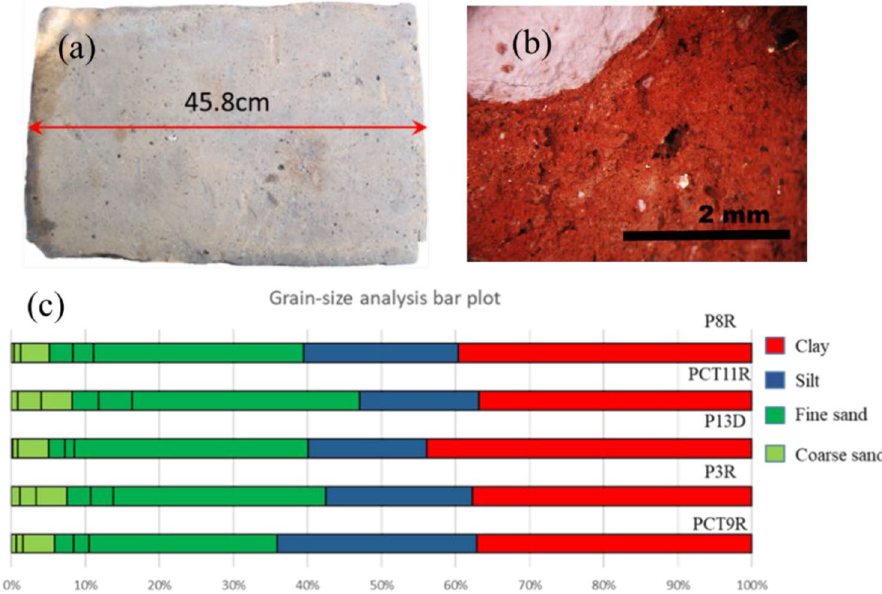
Figure 2. ( a ) The as-excavated burnt brick (denoted B) from Romula. ( b ) Detailed optical image showing the brick B petrographic texture (cross section): note the large white inclusion of CaCO 3 (see text, “Discussion”). ( c ) Particle-size analysis bar plot of the small depth clay soils from Table 1. For the clay soil horizon see Fig. 1b. Fractions (from right to left) are: < 0.002 mm for clay; 0.002–0.02 mm for silt; 0.02–0.05 mm, 0.05–0.1 mm,